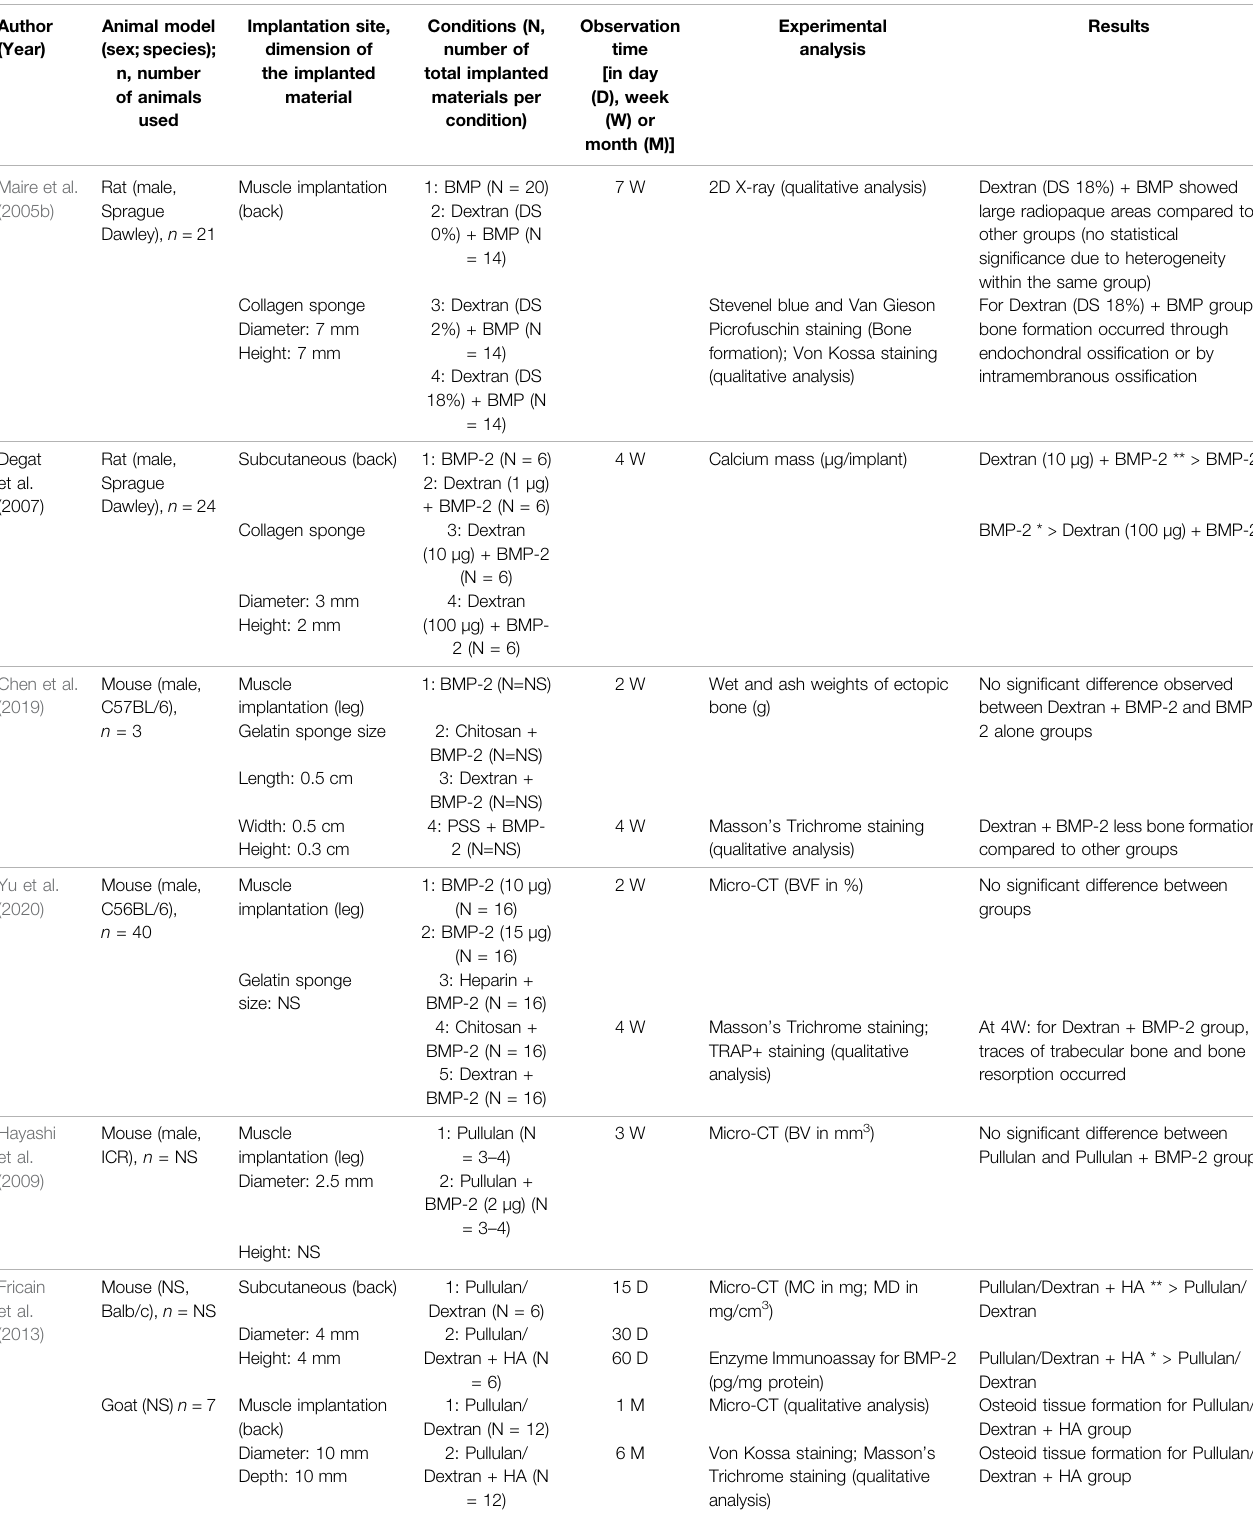
TABLE 2 | Preclinical studies using Dextran and/or Pullulan scaffold in ectopic